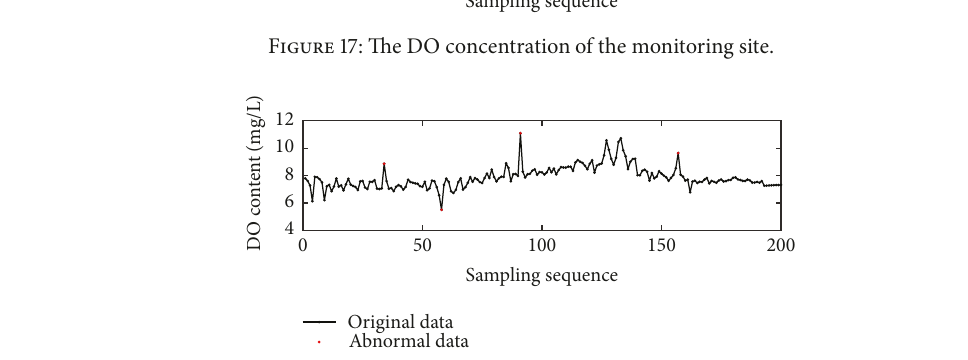
Figure 18: The preliminary outlier detection